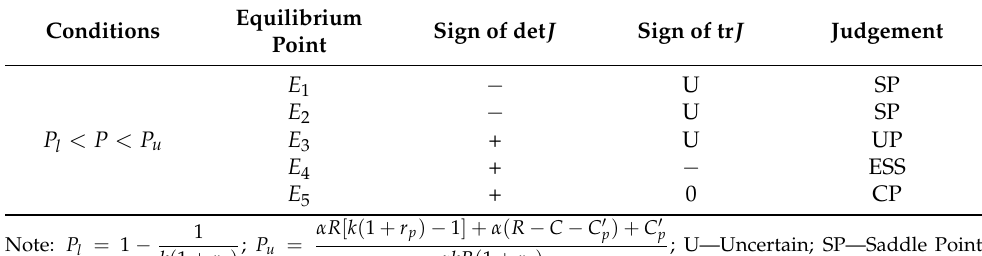
Table 4. Stability judgment and analysis of equilibrium point of accounts receivable factoring